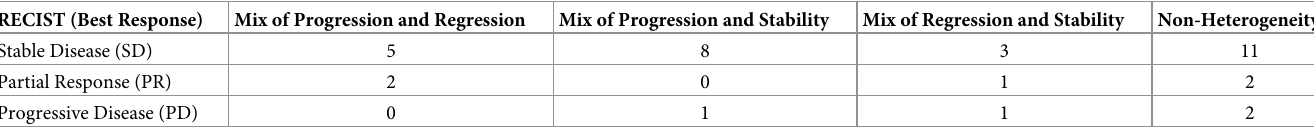
Table 2. Frequency of the heterogeneity associated subgroups in each RECIST response